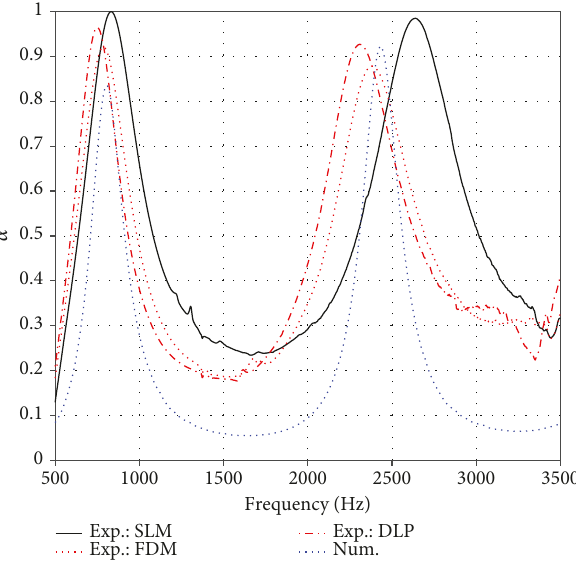
Figure 13: Absorption coe ffi cient for a 10-layer depth of the labyrinth DENORMS cell (equivalent to a 20-layer